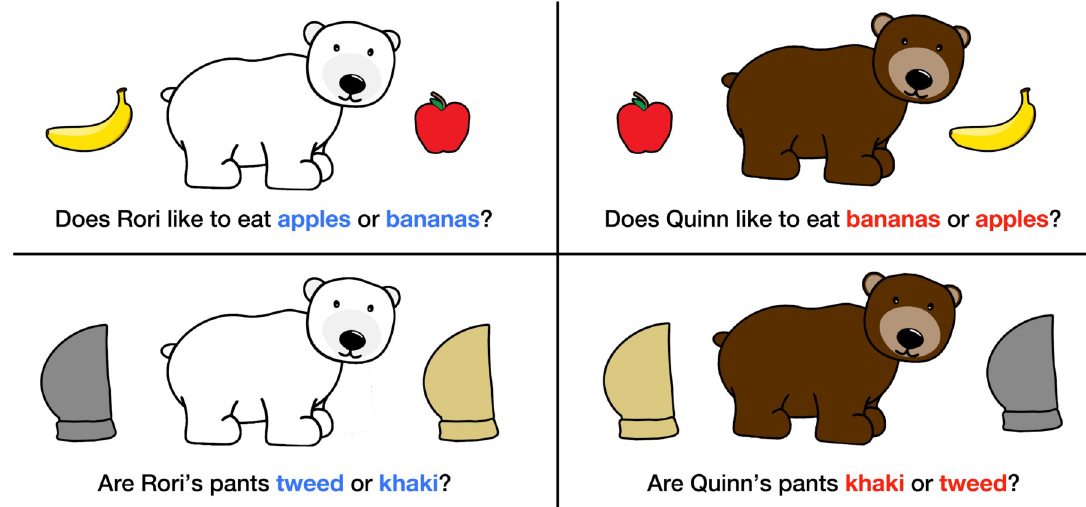
Fig 1. Set up for Experiment 1. Static-cling stickers used in the experiment, along with verbally presented questions. Children were asked a series of questions about each bear–first in one order (e.g., choices in blue on the left) and later in the opposite order (e.g., choices in red on the right). Children were only shown the stickers after they responded to the question